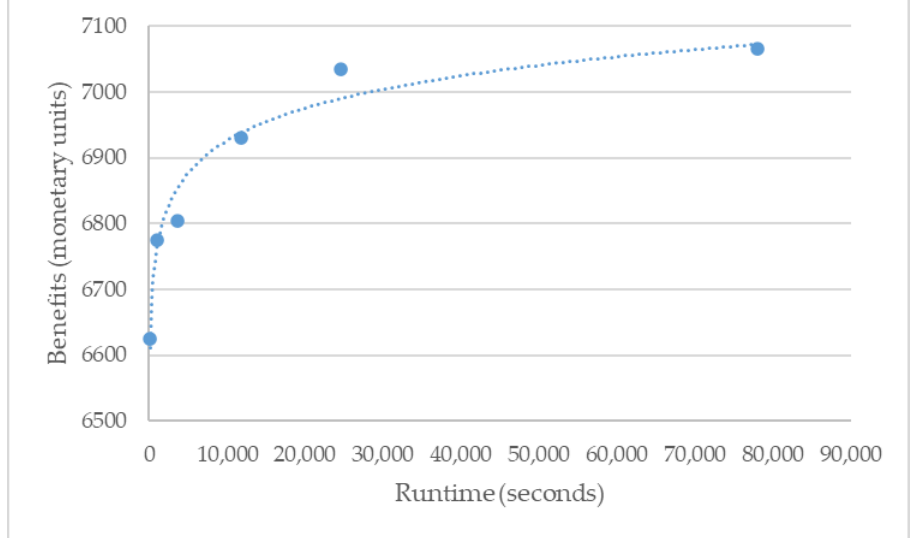
Figure 3. Comparison of improvement over implementation time for the weighted average of 50 neighbors.